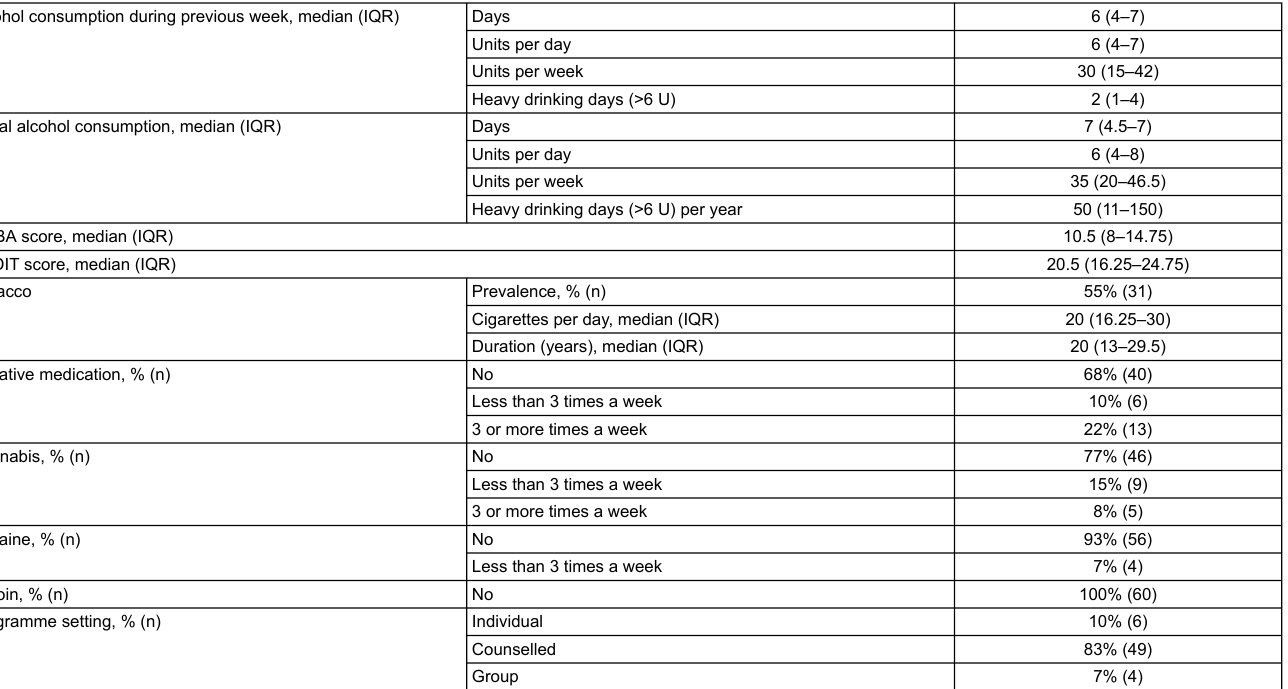
Table 2: Drinking and substance abuse characteristics at